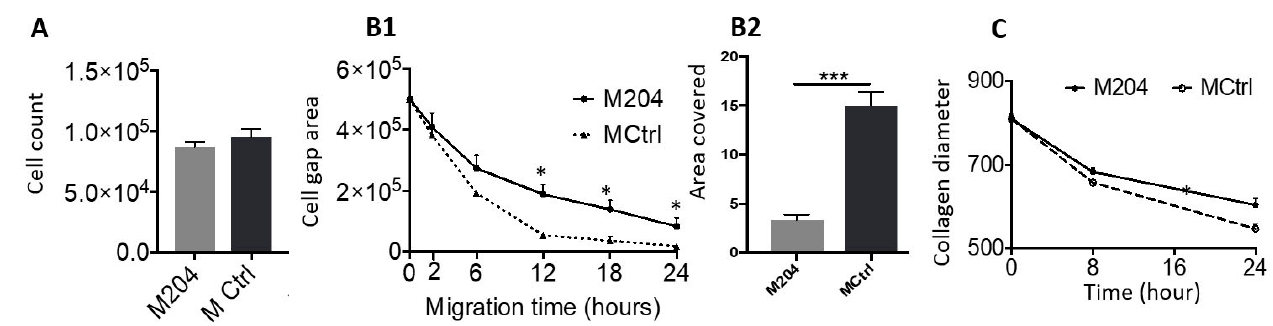
Figure 5. Regulation of ( A ) CAF proliferation, ( B1 ) CAF migration alone, and ( B2 ) in interaction with UK1 and ( C ) CAF collagen contraction ability post miR-204 transfection ( n = 6) (* p < 0.05, *** p < 0.0005).